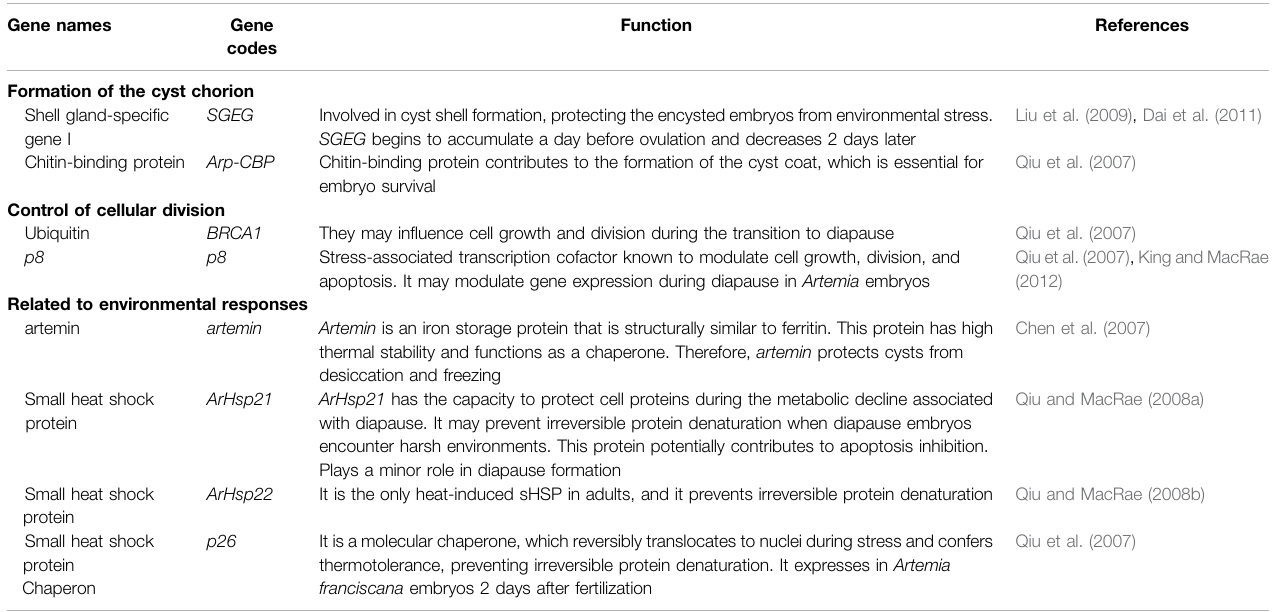
TABLE 1 | Genes related to diapause in Artemia according to